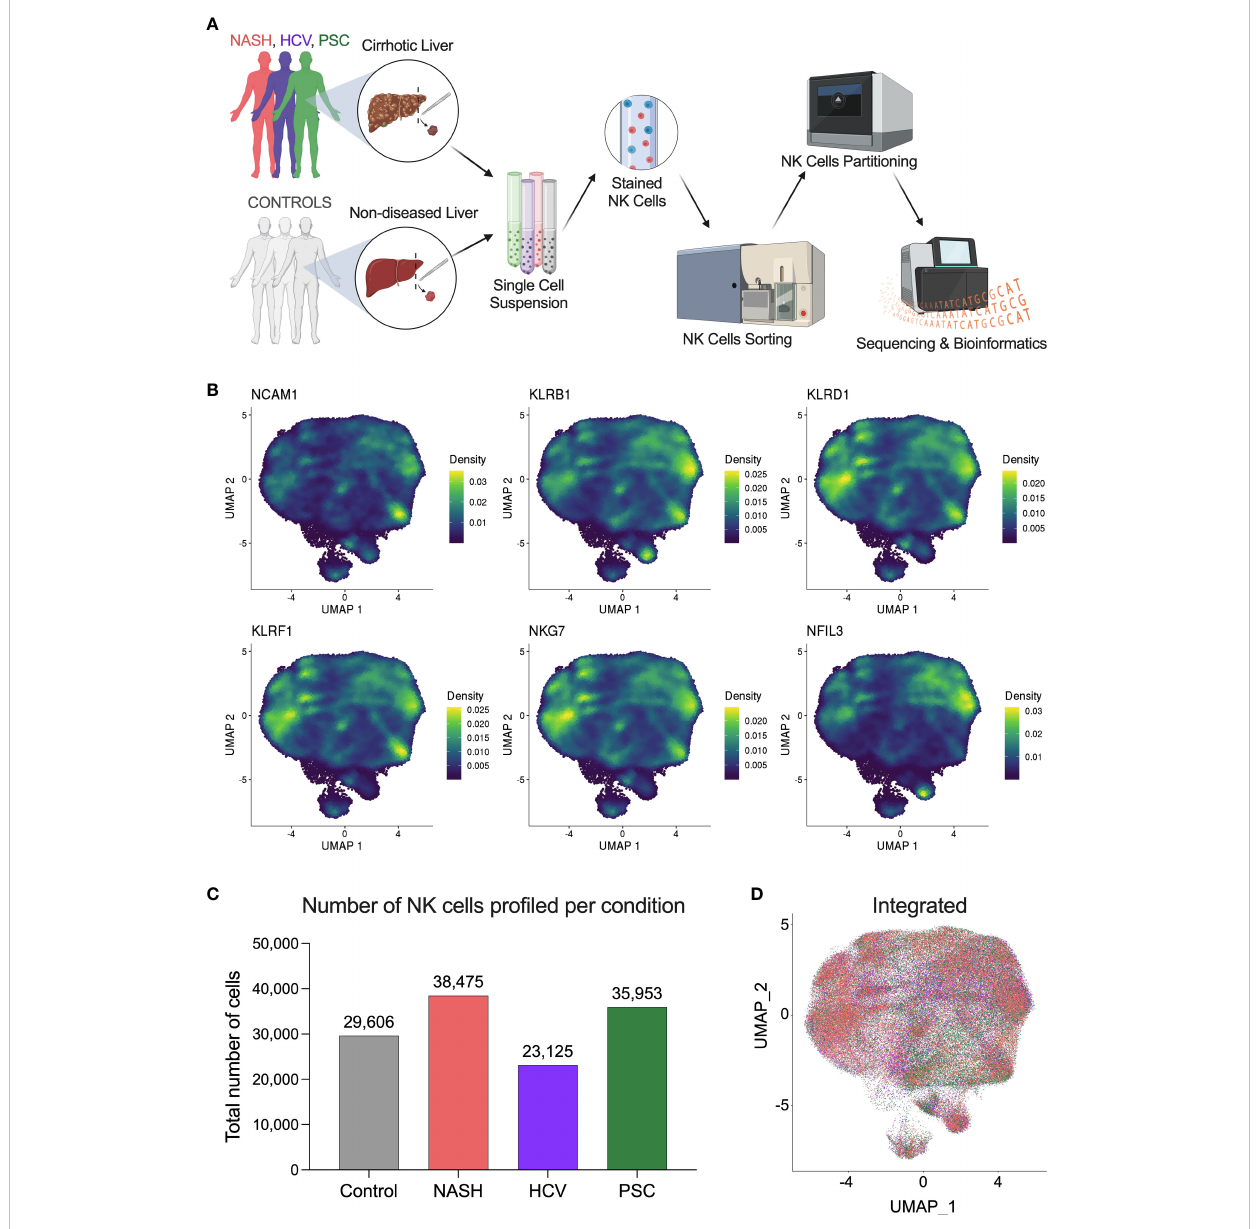
FIGURE 1 Single-cell RNAseq pro fi ling of human hepatic natural killer cells from end-stage chronic liver diseases. (A) Outline of the study experimental design. Liver fragments were processed into single-cell solutions, He-NK cells were FACS-sorted and partitioned for scRNAseq using 10x Genomics technology. Gene expression libraries were sequenced using Illumina platform and processed bioinformatically (Created with BioRender.com). (B) UMAPs show the density of cells expressing the classic markers used to con fi rm the identity of hepatic natural killer cells. (C) Total number of NK cells pro fi led in each group (n=4/condition). (D) Integrated UMAP shows the projection of He-NK cells from non-diseased controls (gray), NASH patients (salmon), HCV subjects (purple), and PSC patients